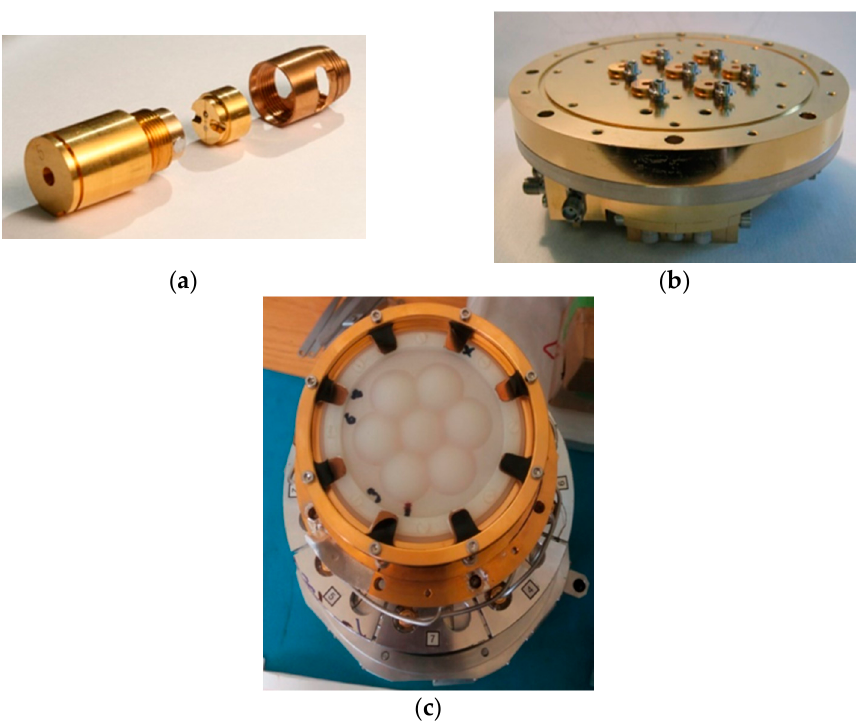
Figure 12. 7-pixel array for high band (790–950 GHz) receiver CHAMP+ at radio telescope APEX (Atacama Pathfinder EXperiment): ( a ) Photo of the pixel mixer block elements, ( b ) 7-pixel mixer array with open horns, ( c ) Lens array at the top of the cartridge body.